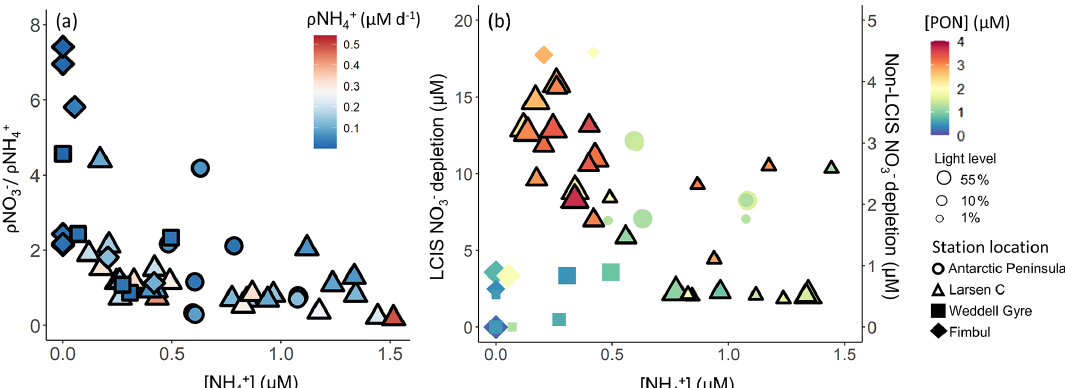
Figure 12. (a) NO 3 − uptake normalized to NH 4 + uptake as a function of NH 4 + concentration and (b) NO 3 − depletion versus NH 4 + concentration. The symbols in panel (a) are coloured by the NH 4 + uptake rate ( ρ NH 4 + ) and in panel (b) by PON concentration. In panel (b) , the symbol size indicates the incubation light level, NO 3 − depletion at LCIS corresponds with the left y axis, and NO 3 − depletion at all other (“non-LCIS”) stations corresponds with the right y